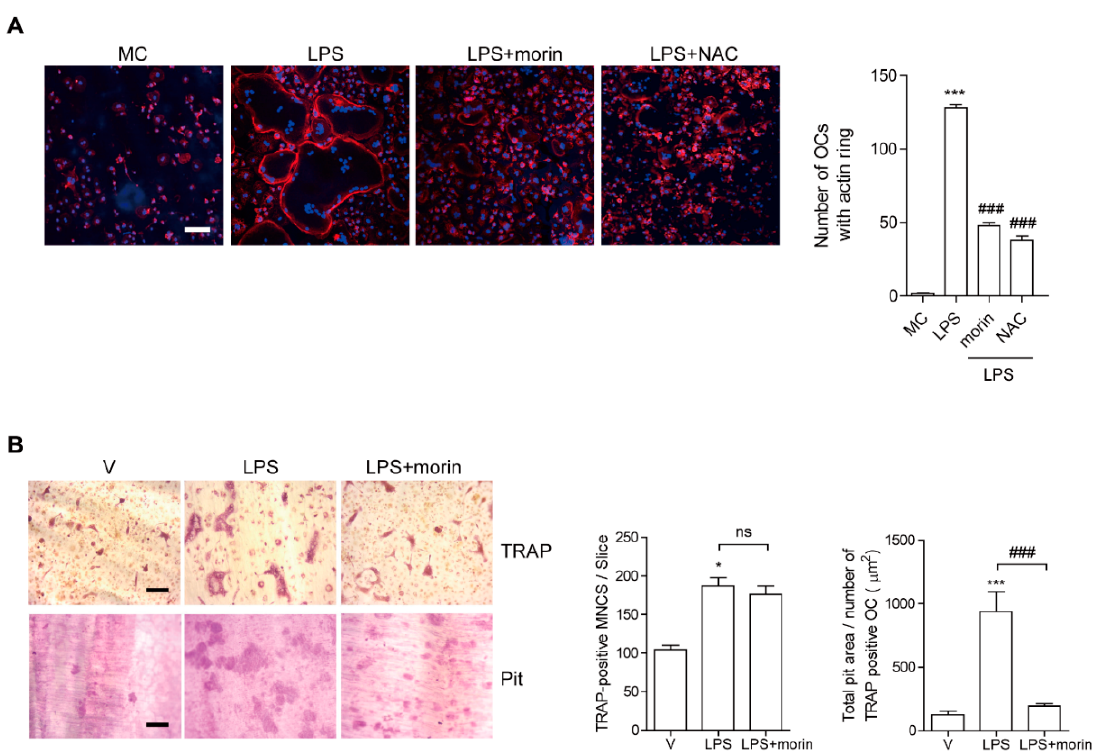
Figure 3. Morin inhibits LPS-stimulated actin ring formation and OC activity. BMMs were cultured with M-CSF (30 ng/mL) and RANKL (40 ng/mL) for 96 h. ( A ) Cells were incubated with α -MEM/10% FBS (medium control, MC) or with LPS (50 ng/mL) ± morin (200 µ M) or NAC (3 mM) in the presence of M-CSF as indicated. After 6 h of incubation, the cells were stained with rhodamine phalloidin (red color) and Hoechst (blue color) to visualize actin rings and nuclei, respectively. Representative images are shown. Scale bar: 100 µ m. The number of OCs with actin rings was plotted for the indi- cated conditions. ( B ) Mature OCs were seeded on dentine slices with M-CSF and LPS ± morin (200 μ M) for 4 days. Cells were stained for TRAP to measure the number. After cells were removed, slices were stained for toluidine blue to calculate the resorption pits. Representative photos of TRAP-positive OCs and resorption pits are shown. Scale bar: 100 µ m. The total pit area/number of TRAP-positive OCs was calculated. * p < 0.05, *** p < 0.001 compared with MC or vehicle; ### p < 0.001 compared with LPS. Similar results were obtained in three independent